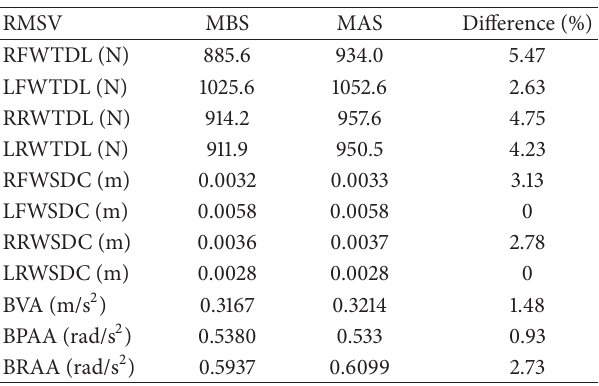
Table 3: Contrasting data of the MBS and